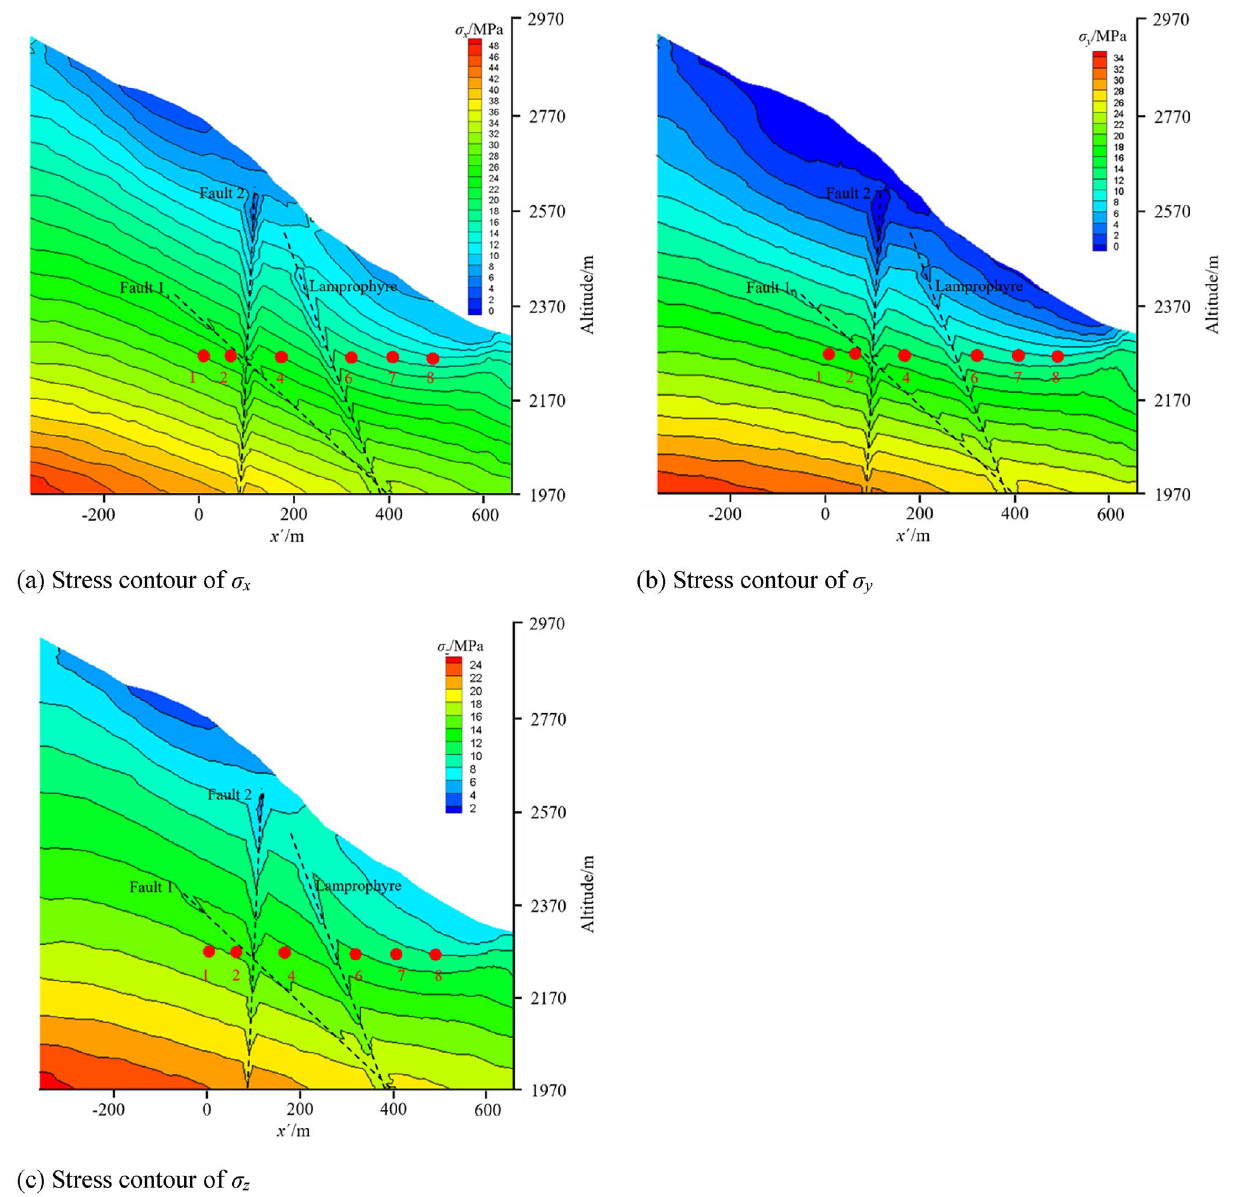
Figure 9. Stress contour of σ x , σ y , σ z at y ′ =